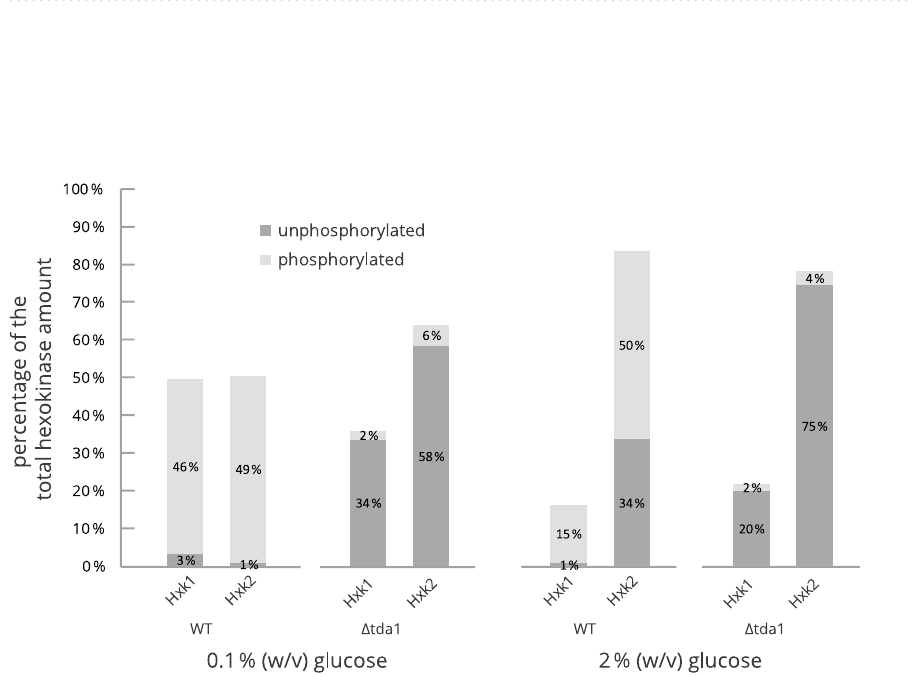
Figure 4. Relative quantification of hexokinase isoenzymes Hxk1 and Hxk2. Based on 2D-DIGE fluorescence data, measurements of the relative amounts of hexokinases present in the wild type and the Δ tda1 deletion mutant proteomes after cell growth at different initial glucose concentrations (0.1% or 2% (w/v)) were obtained by model-based quantification (for details, see the Experimental procedures section). The spot volumes calculated from the 2D-DIGE fluorescence scans for the main spots containing hexokinases (spots 915, 916, 938, 942) were averaged by calculating the geometric mean and expressed as percentages of the total sum of the four spot volumes. Deviations from the total hexokinase amount of 100% are caused by rounding the displayed values to the nearest integer. See Fig. 3 for an impression of the spot landscapes used as the basis for